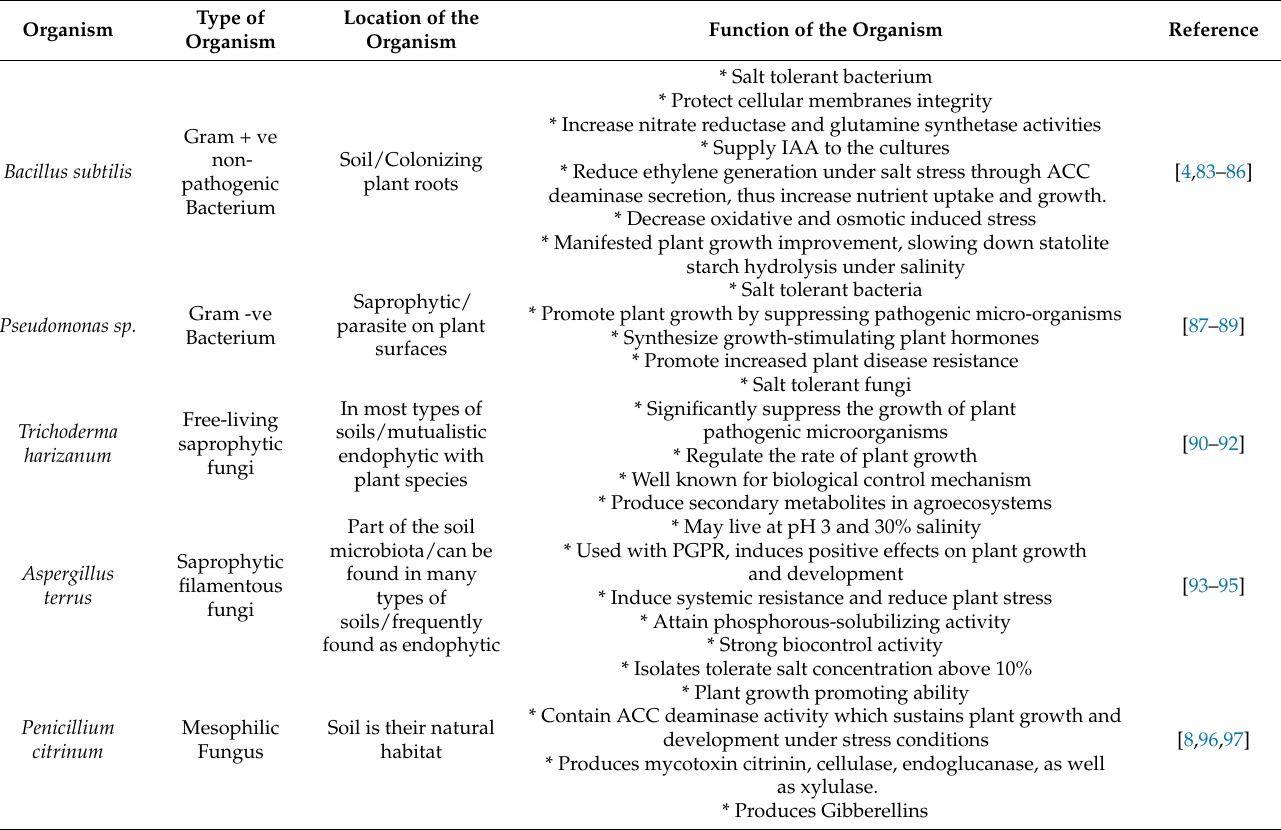
Table 4. Microbial load (bioinoculum I) characterization applied on Solanum melongena L. after exposure to 200 mM NaCl salinity